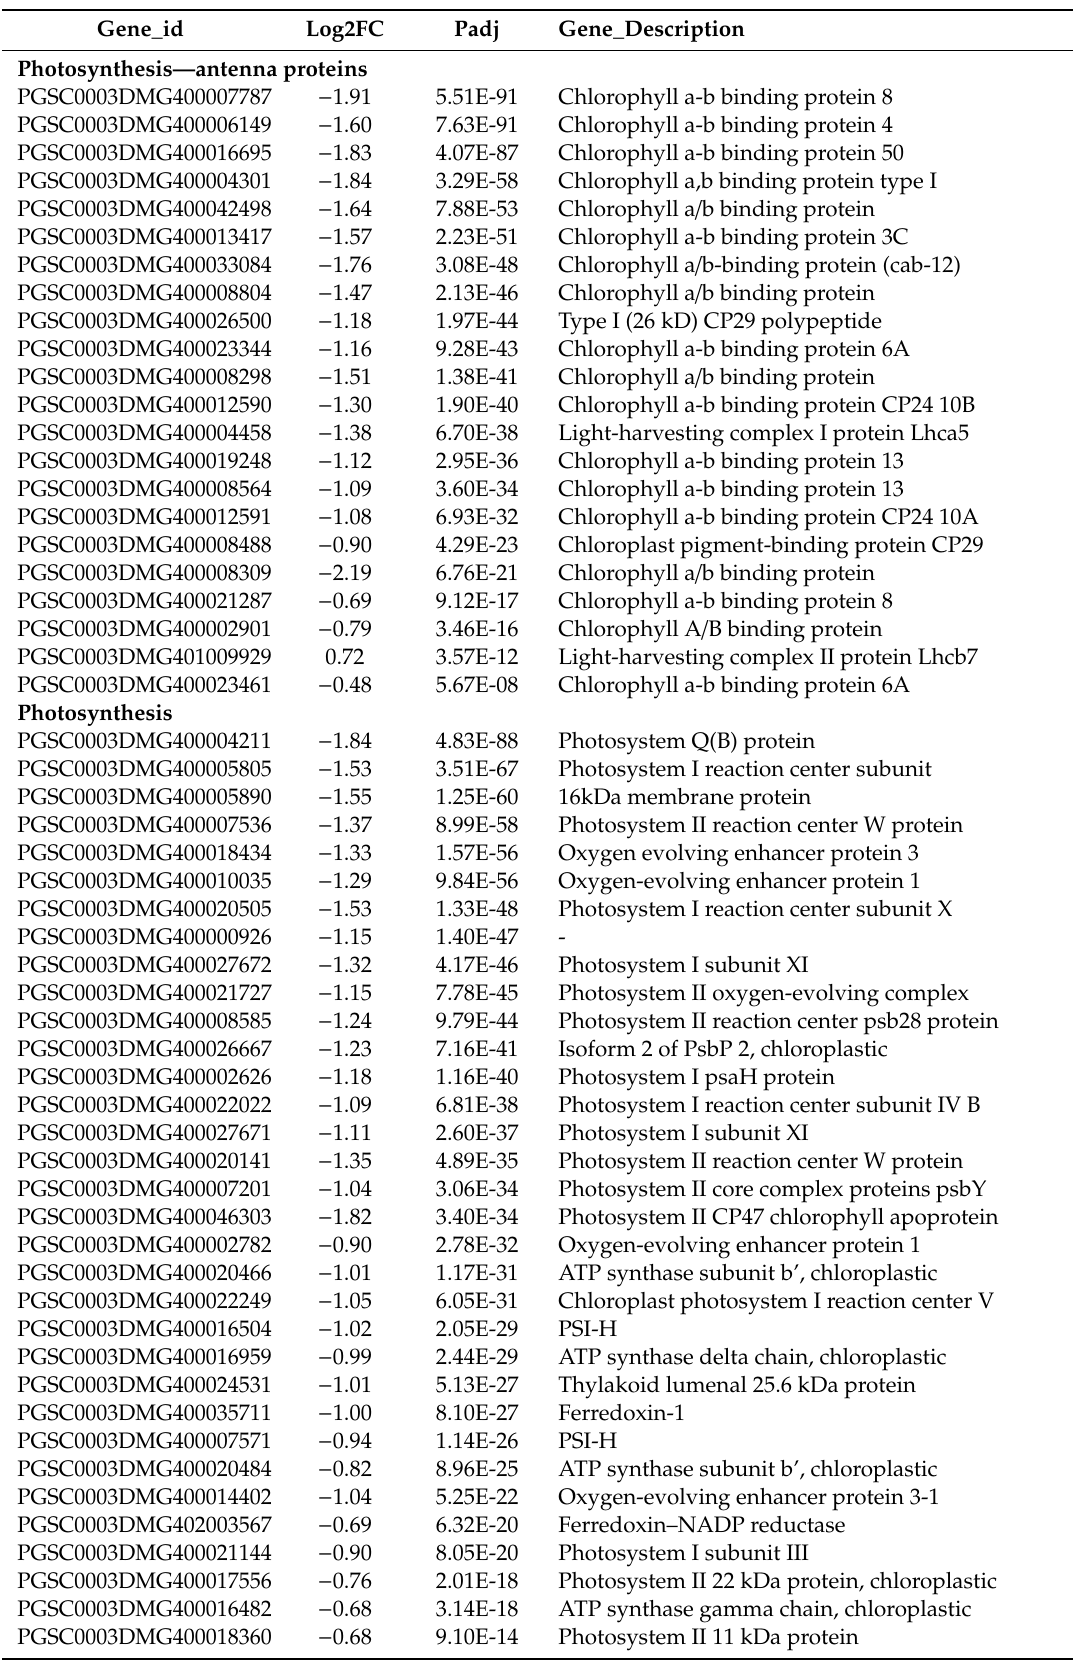
Table 2. StABI5 involved in the regulation of photosynthesis in